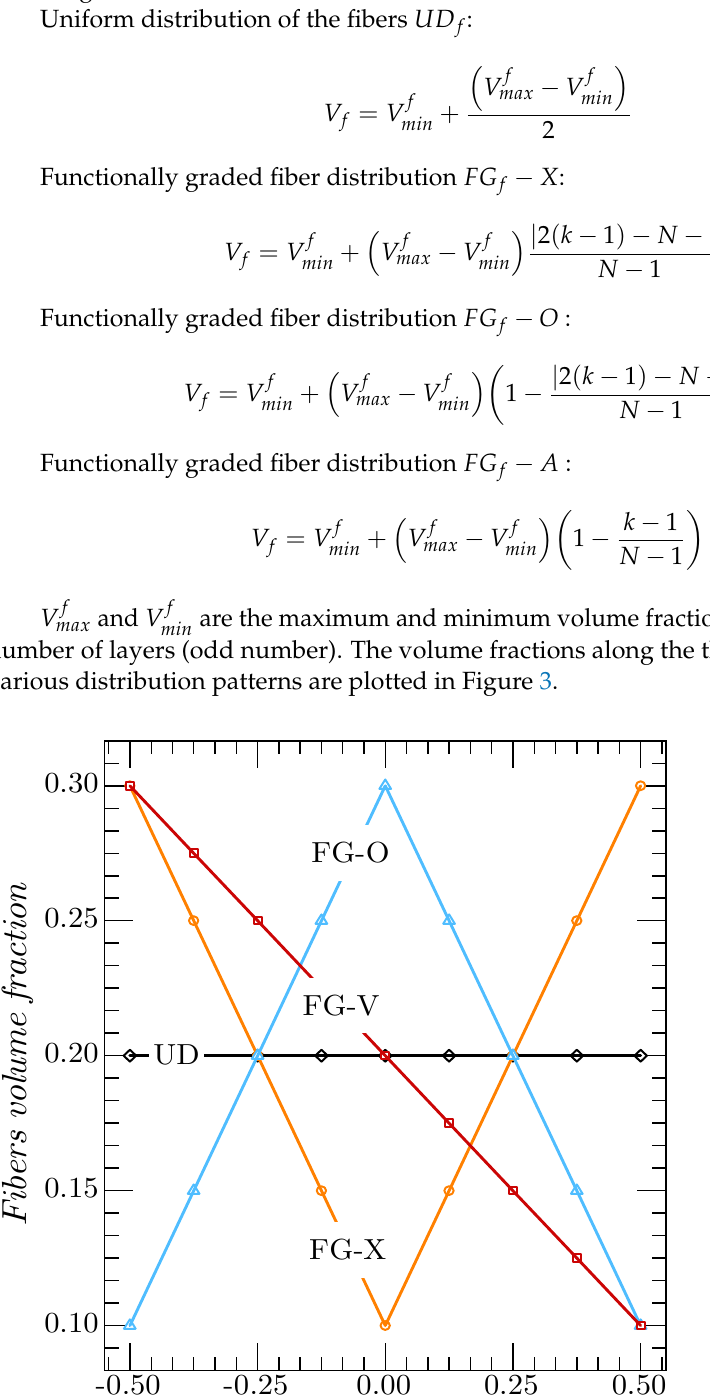
Figure 3. The volume-fractions of the fibers along the thickness of the shell ( V f max = 0.3, V f 0.1 ).